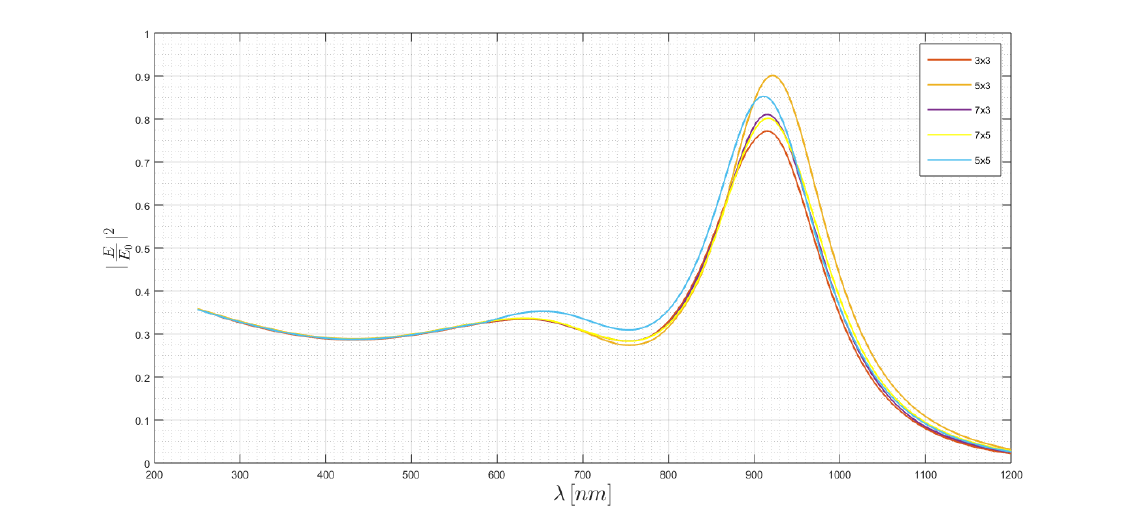
Figure 17. Sweep of the number of holes that composed the copper